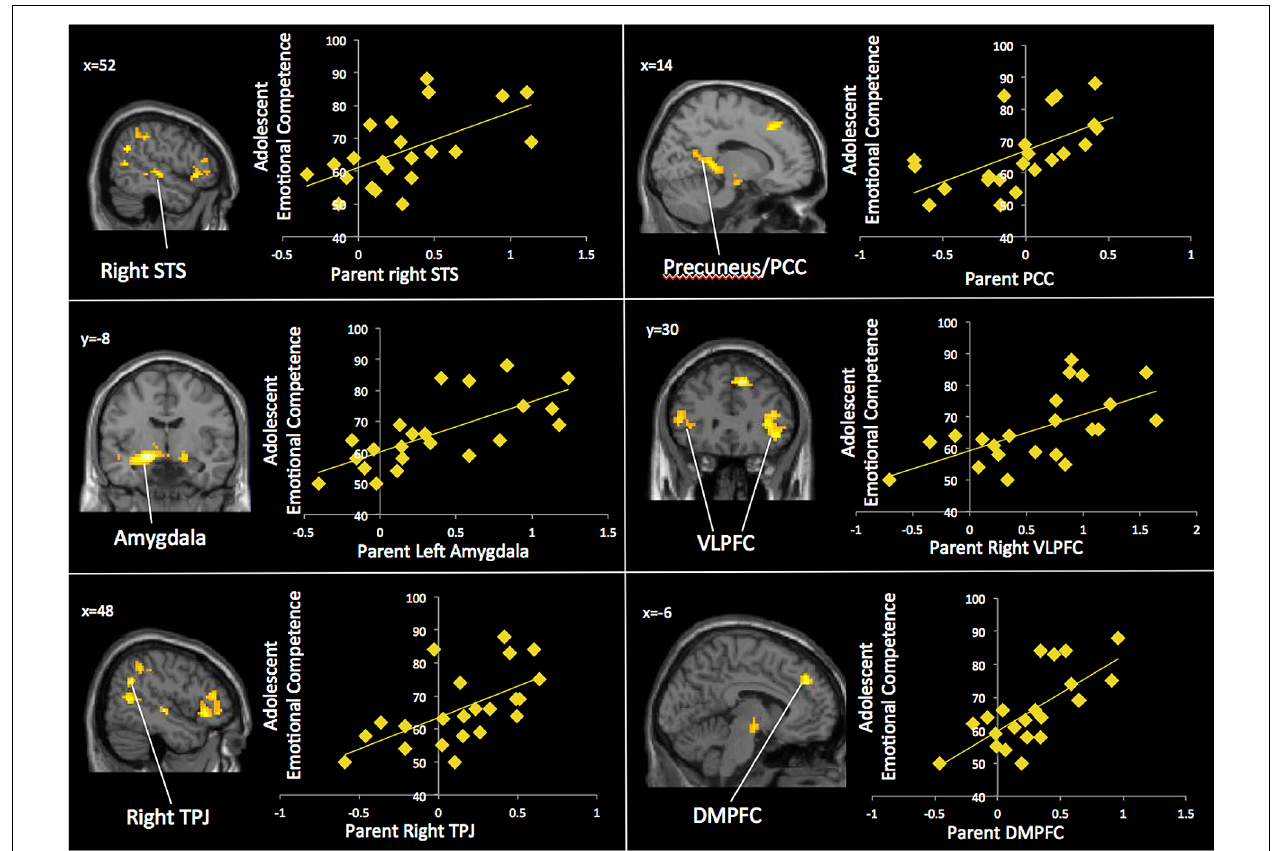
FIGURE 3 | Parents’ neural activation is associated with adolescents’ emotional competence.